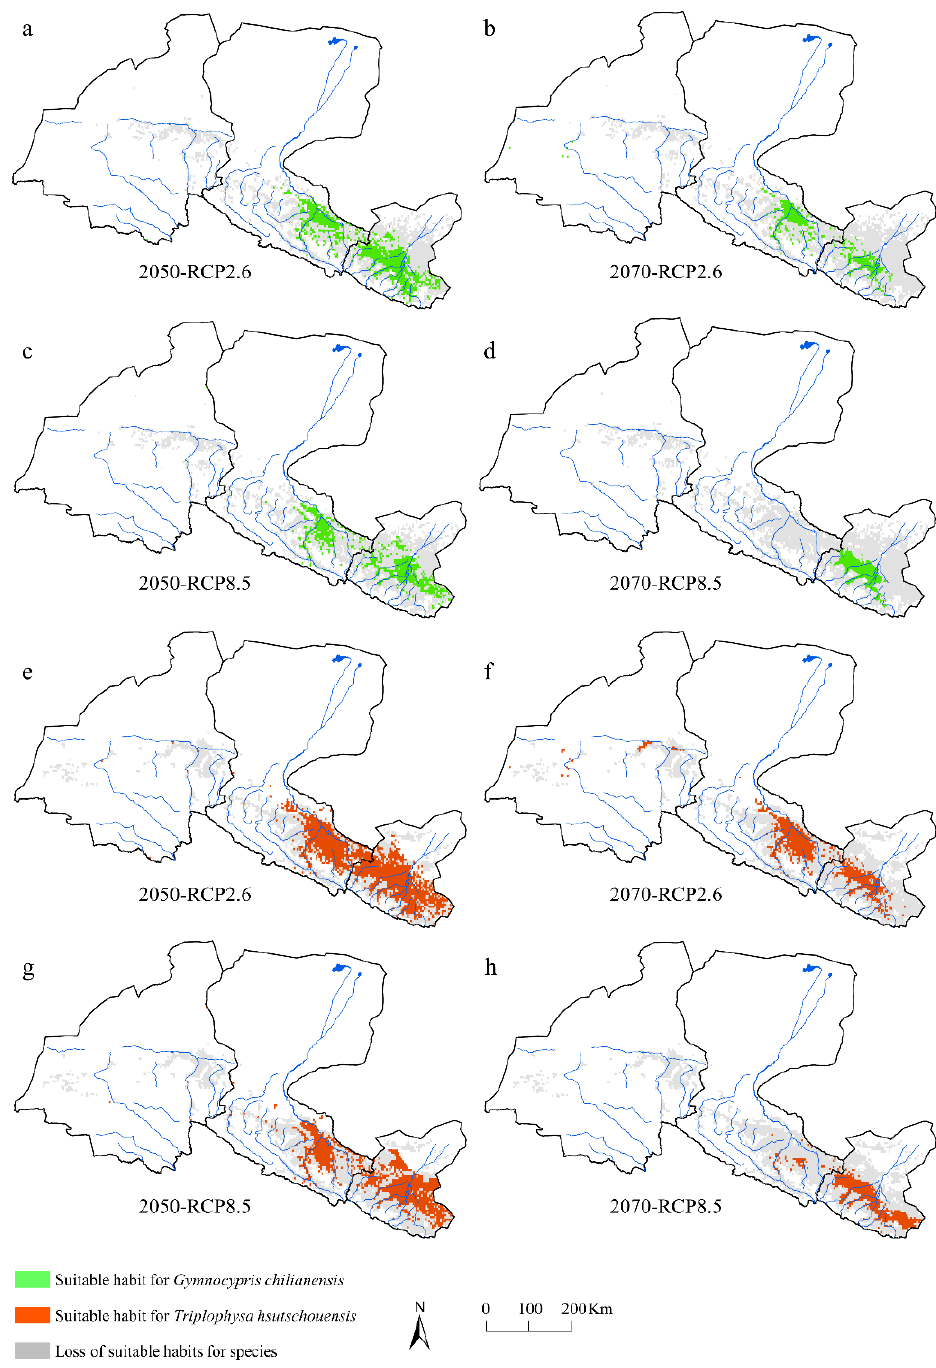
Figure 4. Potential geographical distribution of G. chilianensis ( a – d ) and T. hsutschouensis ( e – h ) under future climate scenarios. Table 4. Changes in suitable habitat areas of G. chilianensis and T. hsutschouensis under future climate scenarios.